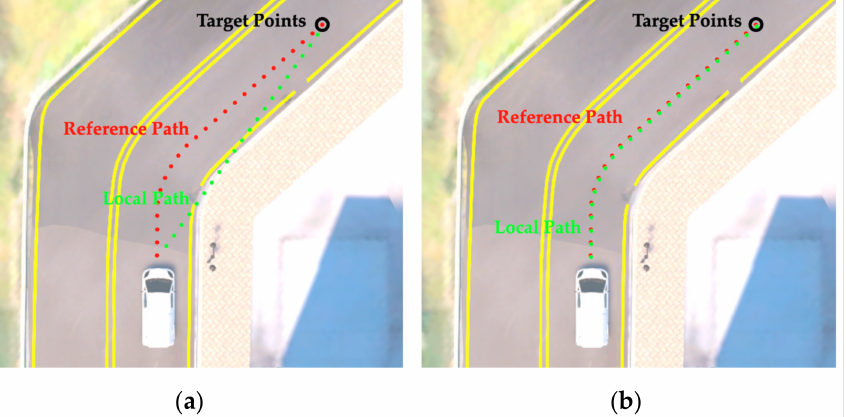
Figure 1. Wrong and correct case of local path planning; ( a ) the case in which the local route penetrates into the side of the road and ( b ) the case where the local route is generated correctly, following the reference path.